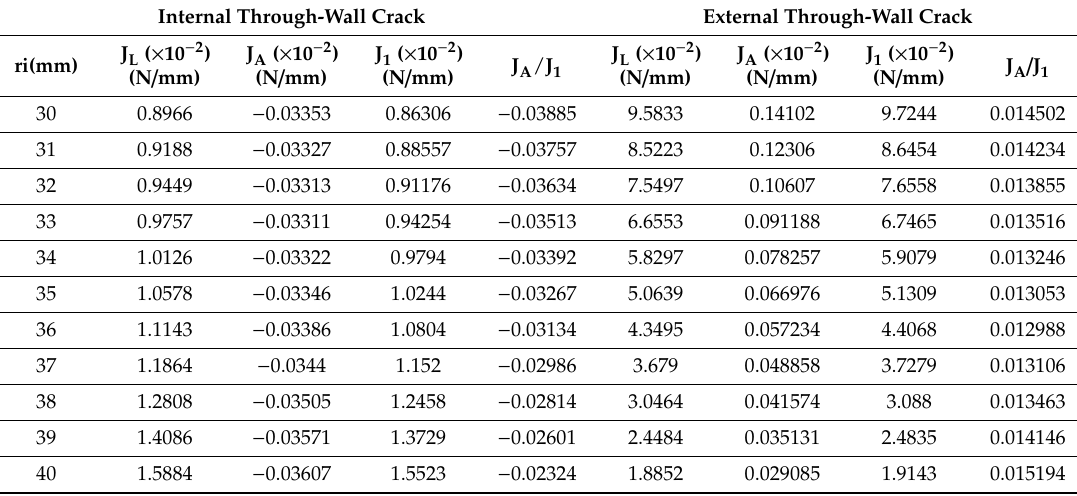
Table 3. Computed J-integral values using the current method and showing the e ff ect of the surface integral